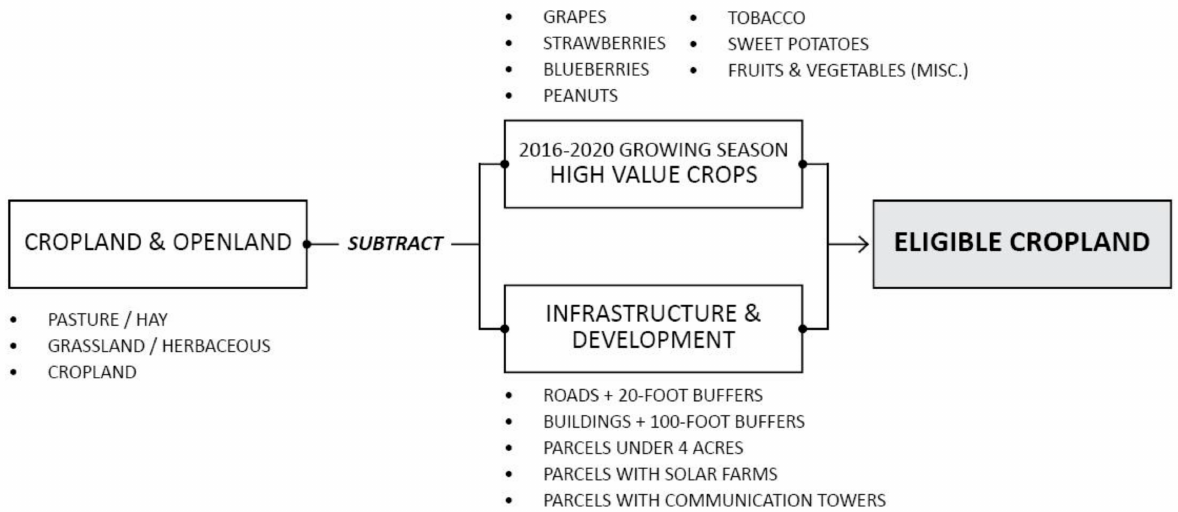
Figure 5. Diagram illustrating the general geospatial overlay analysis process for identifying Eligible Cropland.